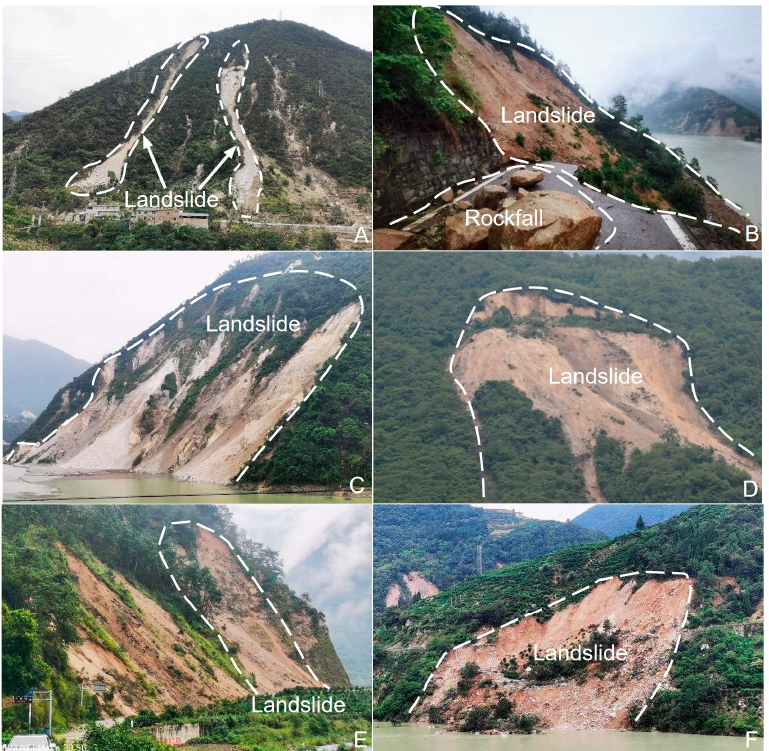
Figure 4. Typical coseismic landslide types induced by the Luding event. ( A ) collapse flow; ( B – F ) soil landslides